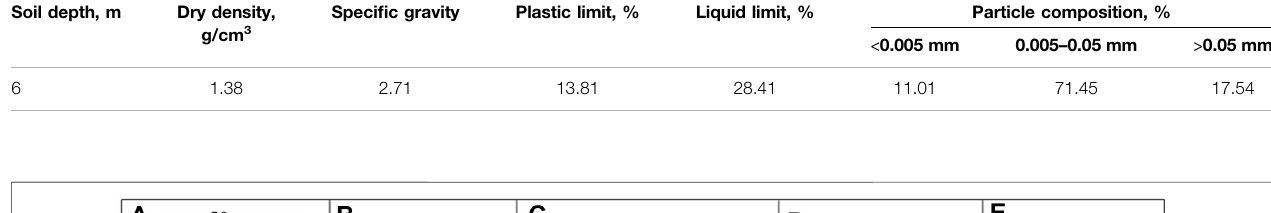
TABLE 1 | Basic physical parameters of the tested samples. Soil depth, m